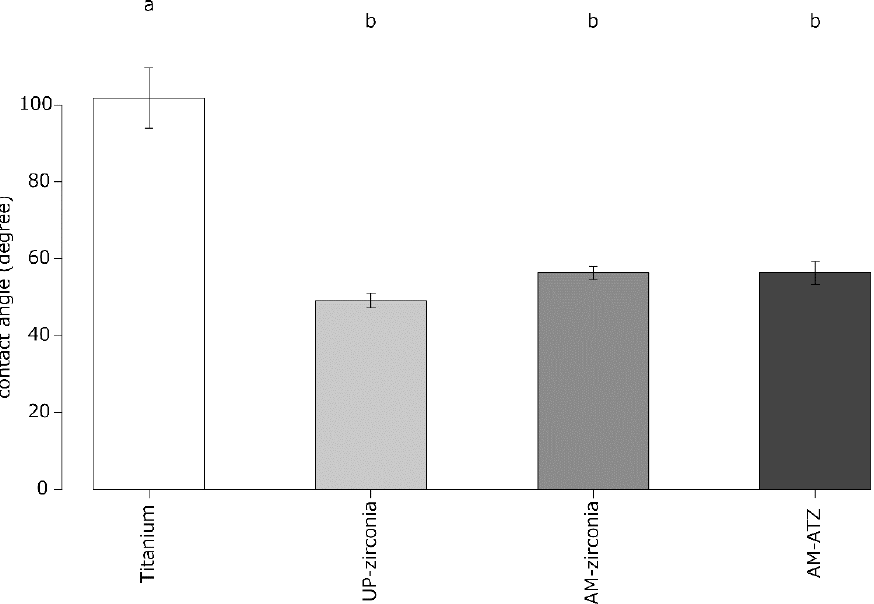
Figure 1. Results of contact angle measurements. Identical letters indicate no statistical difference.